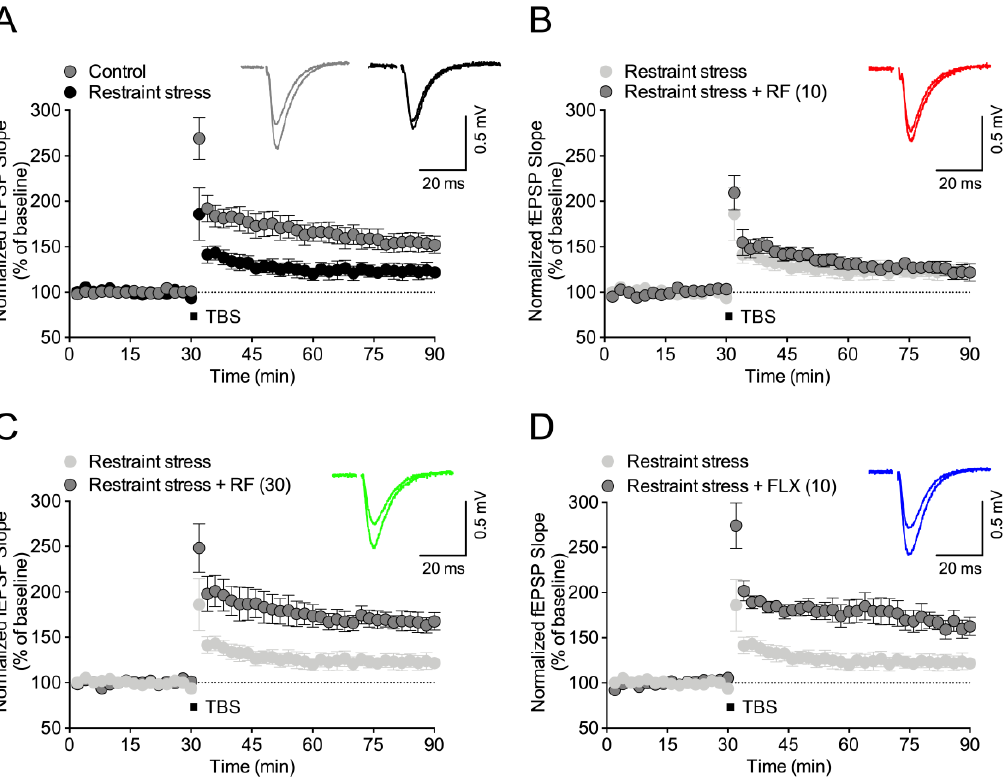
Figure 5. Effect of rubrofusarin on synaptic deficit: Long-term potentiation in the Schaffer-collateral pathway was induced by 2 trains of theta burst stimulation (TBS, 5 trains of 4 pulses at 100 Hz) after 30 min stable baseline. ( A ) Normalized Field excitatory postsynaptic potential (fEPSP) slop of control and chronic restraint stress (CRS) group for 90 min. ( B ) Normalized fEPSP slop of CRS + rubrofusarin (10 mg / kg) group for 90 min. ( C ) Normalized fEPSP slop of control and CRS + rubrofusarin (30 mg / kg) group for 90 min. ( D ) Normalized fEPSP slop of CRS + fluoxetine (10 mg / kg) group for 90 min. Data represented as mean ± SD.